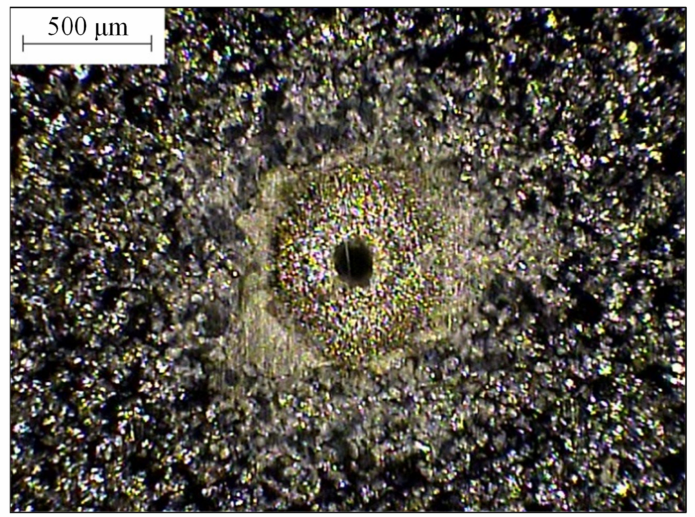
Figure 11. The actual image of the drilled